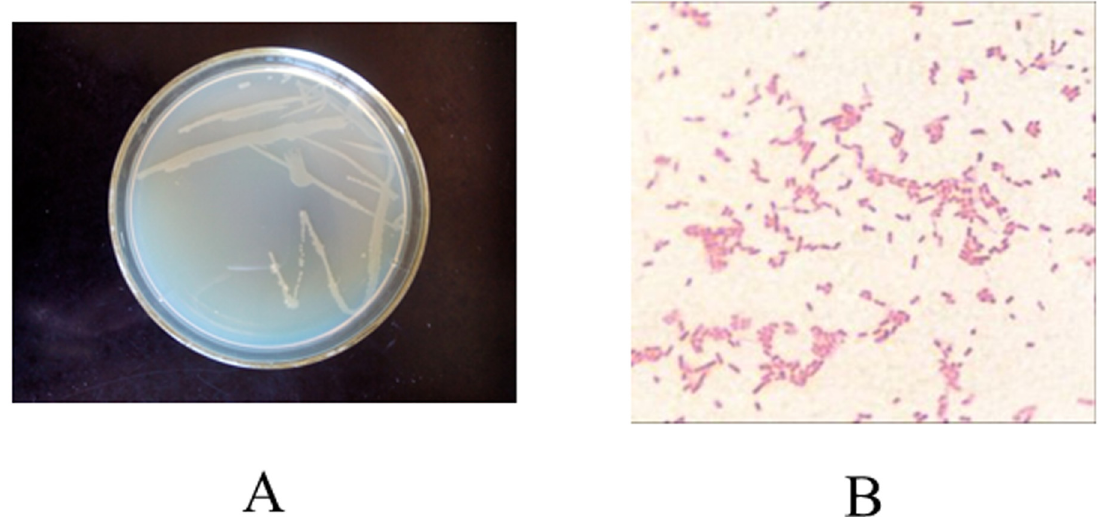
Fig 1. The colony morphology (A) and gram stain (B) of murine bacteria strain